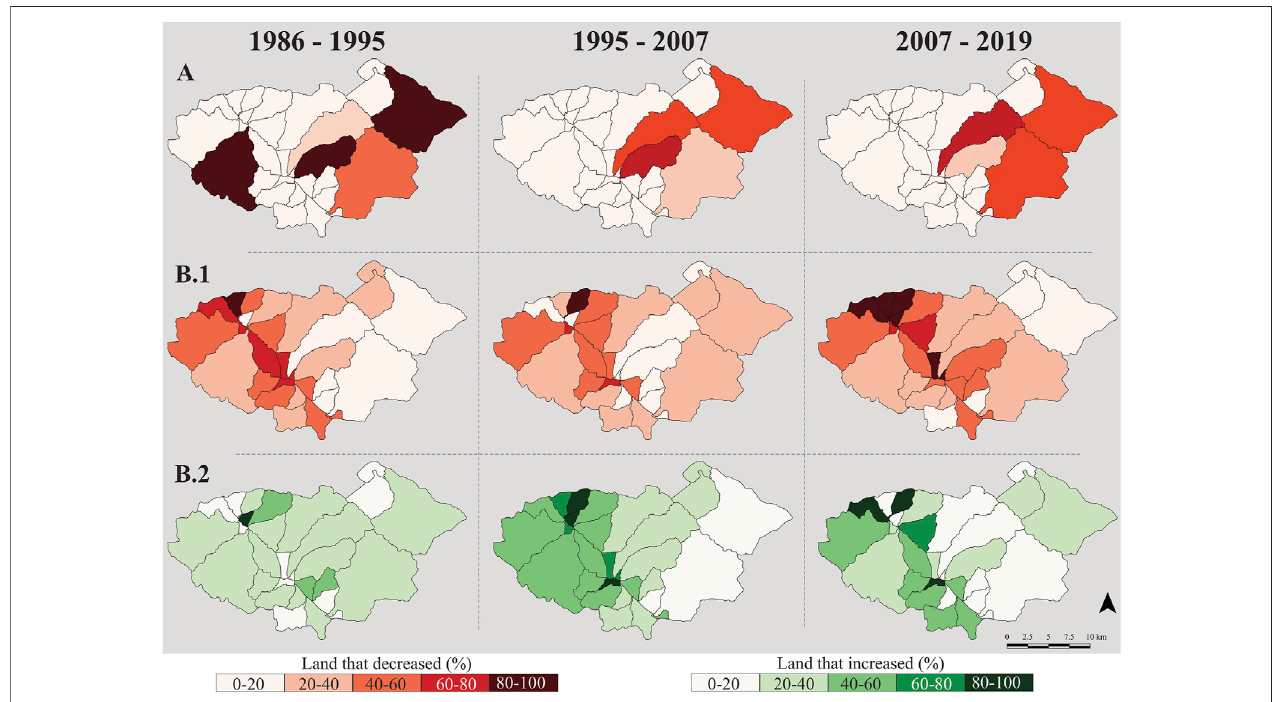
FIGURE 3 | Land decrease intensity of the glaciers (A) and the land decrease/increase intensity of the bofedales (B.1,B.2) at the watershed level in the Marangani district over the three periods.